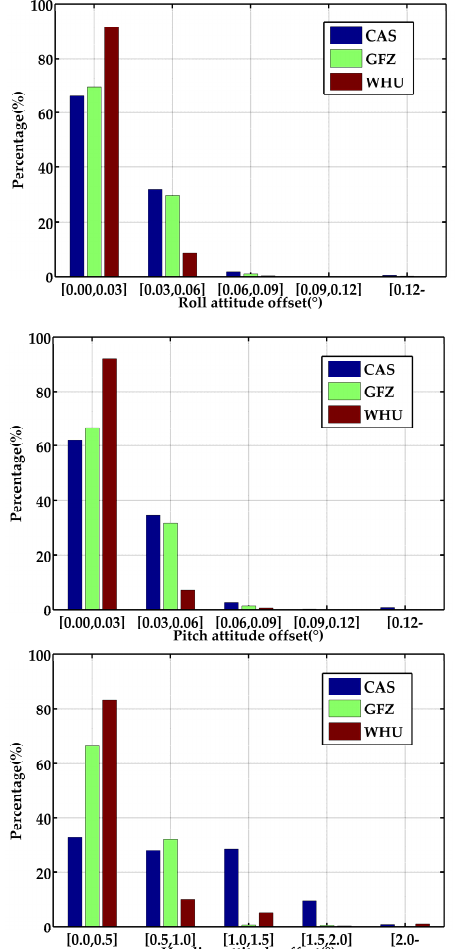
Figure 10. Attitude offsets of G + B SF-PPP/INS tight integration in roll, pitch, and heading directions using the real-time products from CAS, GFZ, and WHU, in terms of reference solutions (the start time is 195,453 s).